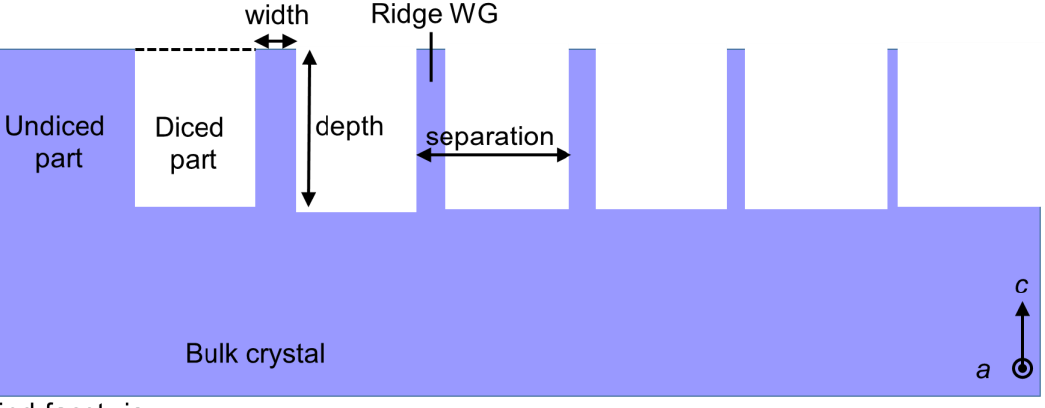
Figure 22. Scheme of the deep diced ridge WGs in bulk Tm 3+ : LiYF 4 crystal (the end-facet view) [111].